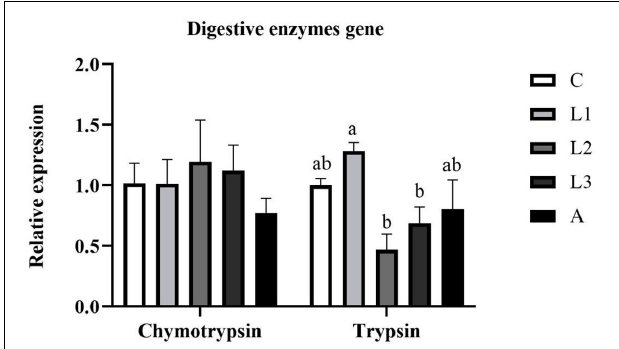
FIGURE 4 | Hepatopancreas RNA expression level of digestive enzyme genes of L. vannamei fed diet supplementation with/without lutein or astaxanthin for 56 days.